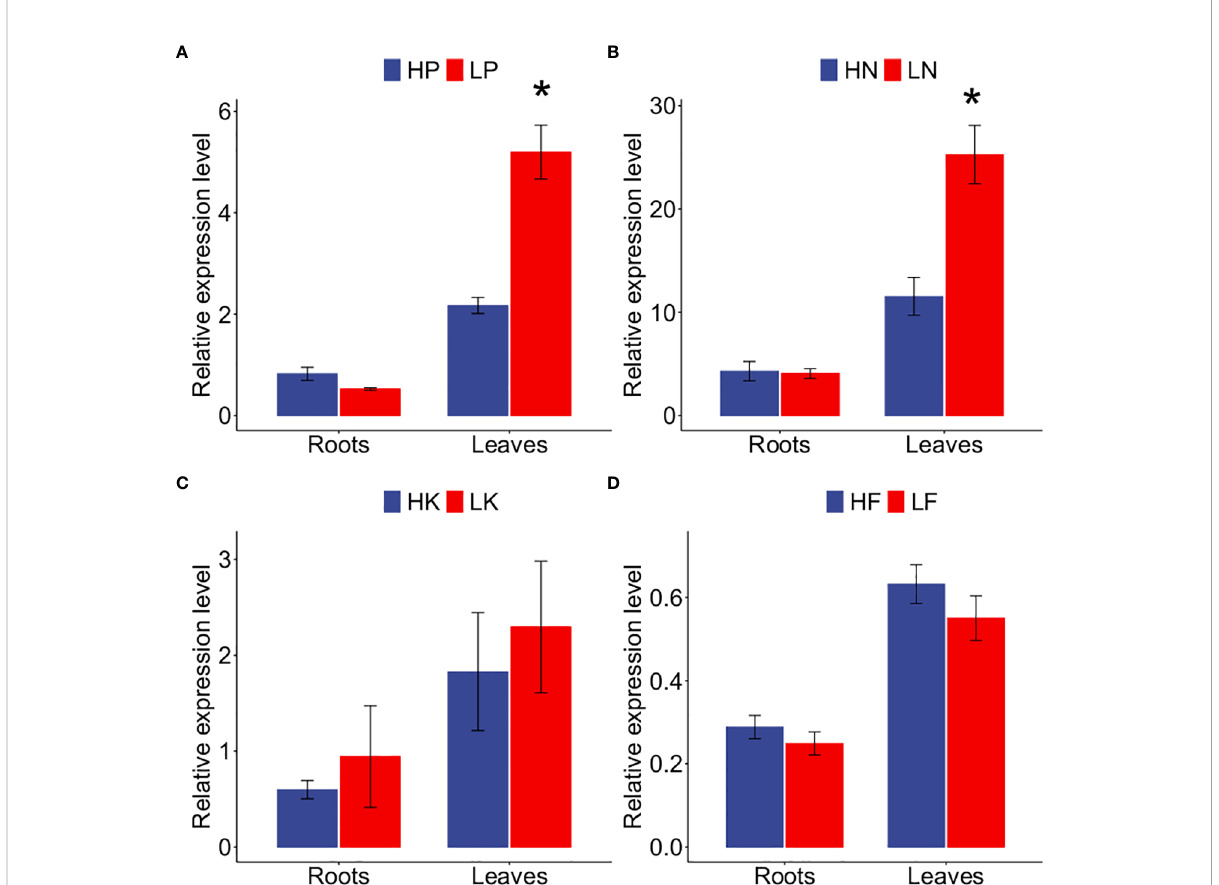
FIGURE 2 Responses of GmNF-YA8 to long-term nutrient starvation in soybean roots and leaves. (A) phosphorus (P) starvation; (B) nitrogen (N) starvation; (C) Potassium (K) starvation; (D) iron (Fe) starvation. HP, 500 µM KH 2 PO 4; LP, 25 µM KH 2 PO 4 ; HN, 3mM nitrogen; LN, 300 µM nitrogen, HK, 2 mM potassium; LK, 250 µM potassium; HF, 50 µM Fe-EDTA; LF, 0 µM Fe-EDTA. Results are means ± SE from 3 independent experiments. Student ’ s t -test were used to explore the differences between control and nutrient de fi ciency conditions (* P <